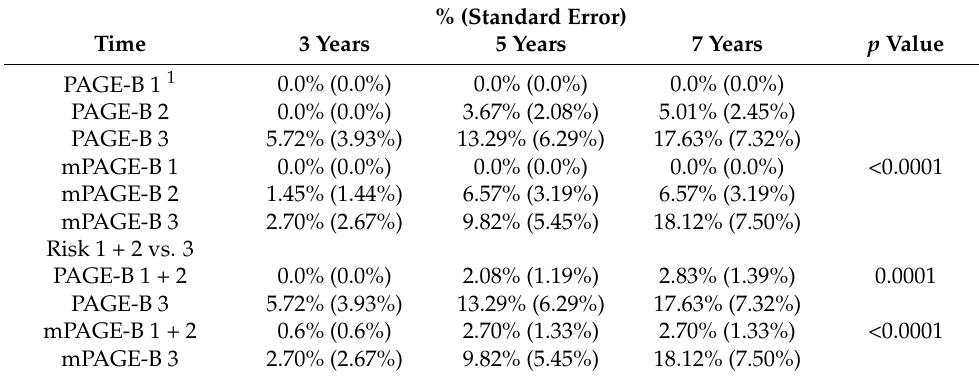
Table 4. Cumulative probability of hepatocellular carcinoma according to the scores.